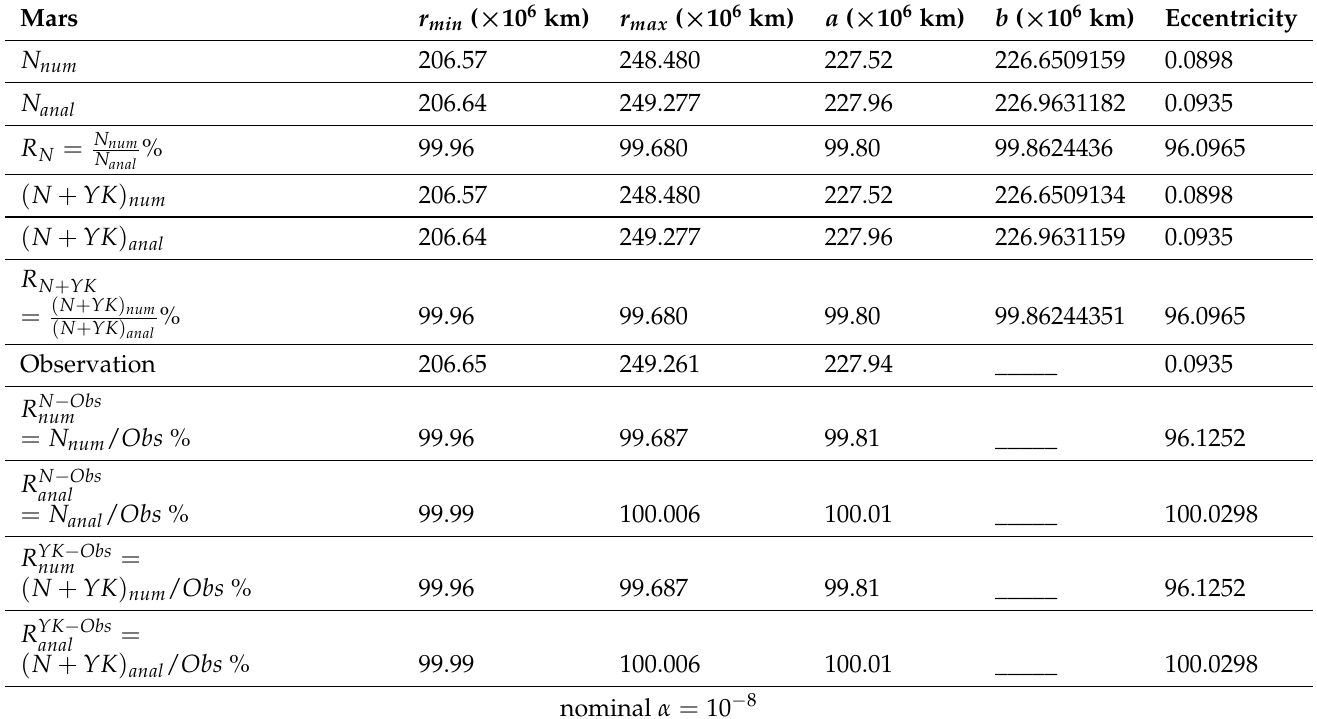
Table A7. The values of the calculated and observational astronomical parameters, for nominal α , of the planet Mars, whose number of moons is